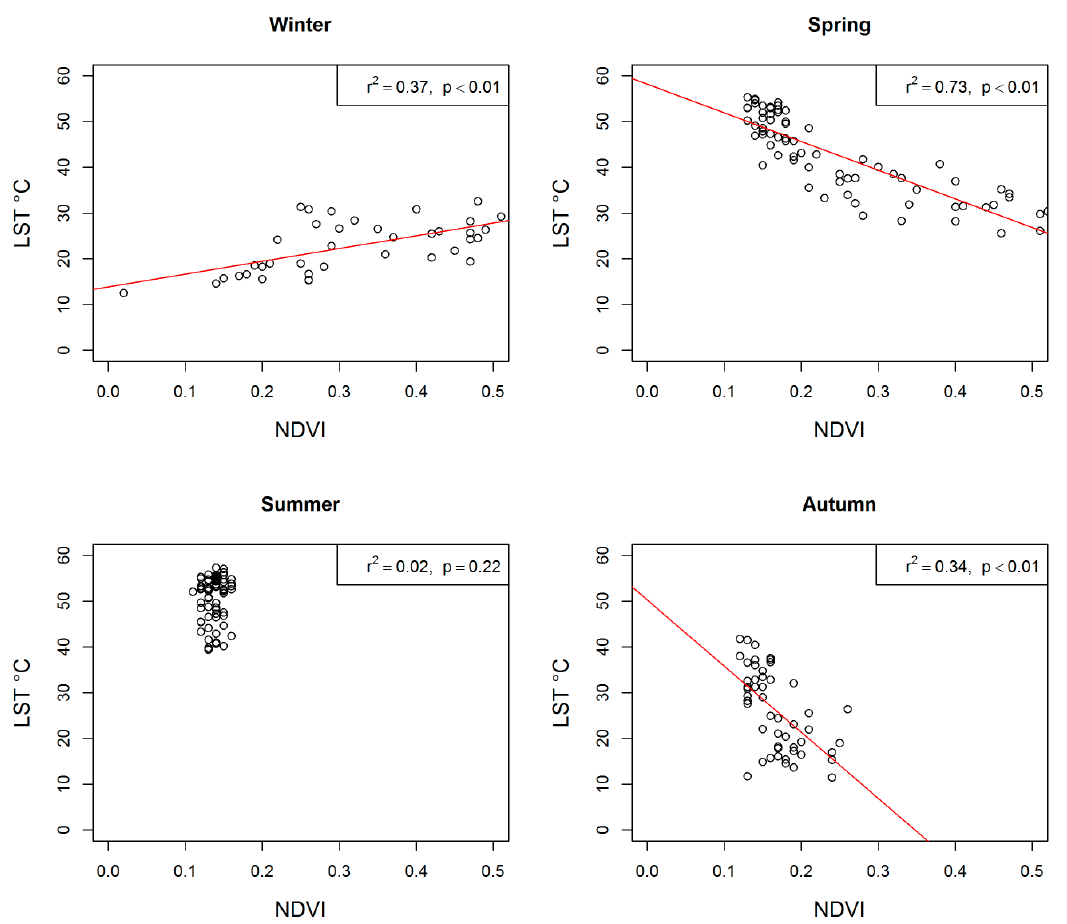
Figure 6. Relationship of Land Surface Temperature with NDVI, fsm and NMDI, from MODIS data.